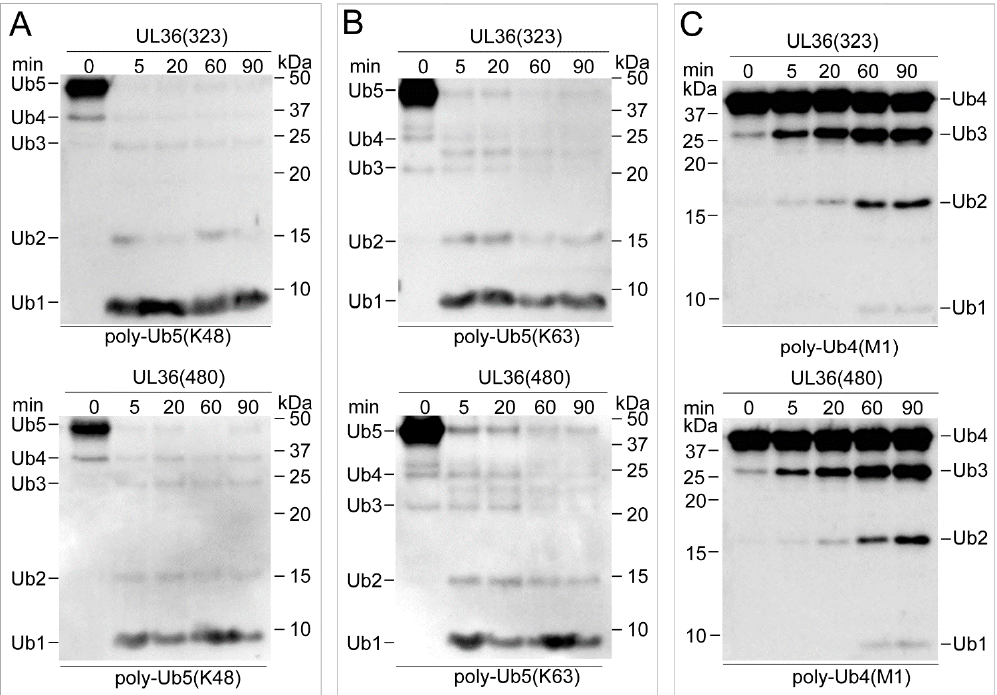
Figure 4. Characterization of substrate preference of UL36(323) and UL36(480) using poly-Ub chains. (A − C) The identification of UL36-DUBs digestion products on various types of poly-Ub chains by Western blotting. The labels under each image indicate different linkage types of Ub polymer. Labels on the sides of each image represent different lengths of Ub; Ub1, Ub monomer; Ub2, Ub dimer; Ub3, Ub trimer; Ub4, Ub tetramer; Ub5, Ub pentamer; M1, linear type of polyubiquitin chain. The numbers